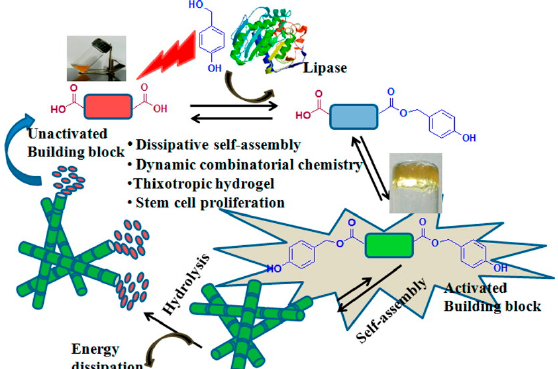
Figure 17. Schematic of gel formation for a bolamphiphile peptide-based hydrogel with self-assembly process mediated by a lipase-catalyzed reaction. Image adapted with permission from reference [78]. Copyright 2015 American Chemical Society.